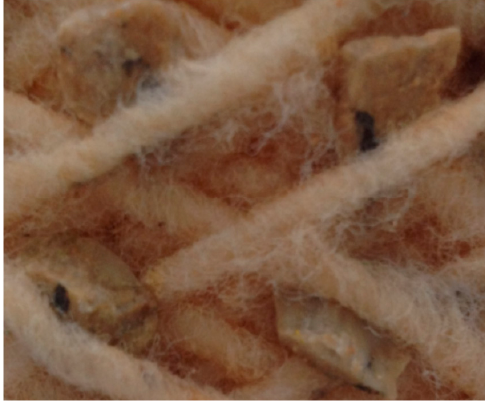
Figure 6. Fine gravel clogging.